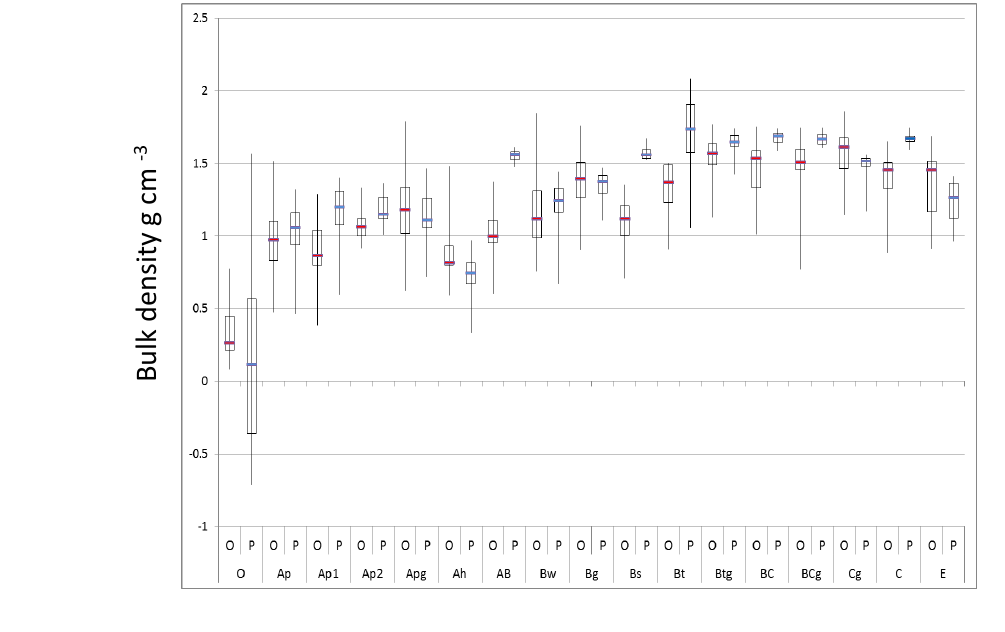
Figure 3. Observed bulk density (O) and predicted bulk density (P) gcm − 3 , for each horizon type. Prediction based on selected PTF with best R 2 p R following prediction quality